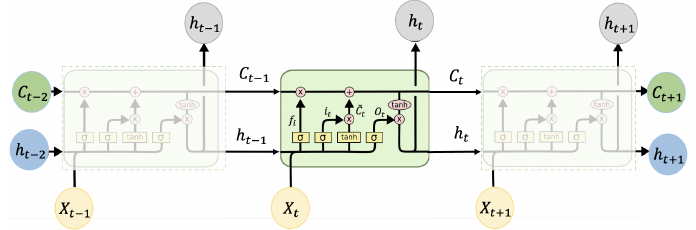
Figure 7. The hierarchical structure of LSTM.